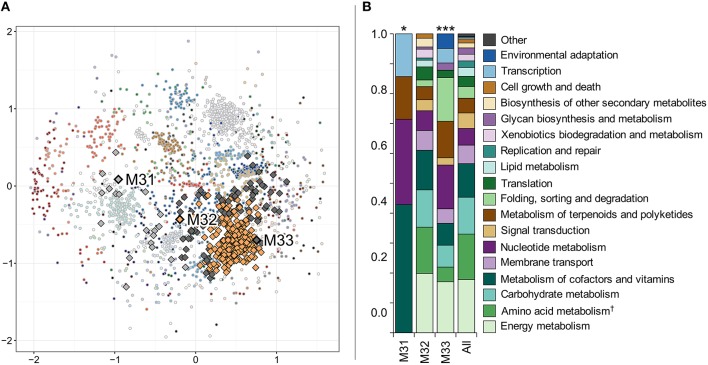
Hierarchical clustering of Nodularia spumigena gene expression patterns based on Pearson correlation distance (A) and functional classification of the three clusters containing metacaspases M31–M33 (B). Each dot in (A) represents one gene and each color represents one of the 62 clusters. The genes have been placed according to their non-metric multidimensional scaling coordinates in two dimensions based on the Pearson correlation distance matrix. The three metacaspases M31 to M33 and their clusters (defined by a hierarchical clustering tree cut into clusters to yield the highest average silhouette width; see Materials and Methods) have been emphasized with a black outline and larger markers. (B) shows gene functions of the metacaspase-containing clusters based on KEGG ortholog annotations. A chi-square test was performed in order to determine whether the distribution of functions was significantly different in the metacaspase clusters compared to all expressed genes in Nodularia spumigena. The results are shown above the bars representing each cluster (*p < 0.05 and ***p < 0.001). “Amino acid metabolism†” is the combination of the categories “Amino acid metabolism” and “Metabolism of other amino acids.” The “Other” functional category consists of “Cell motility,” “Drug resistance,” and “Transport and catabolism.”